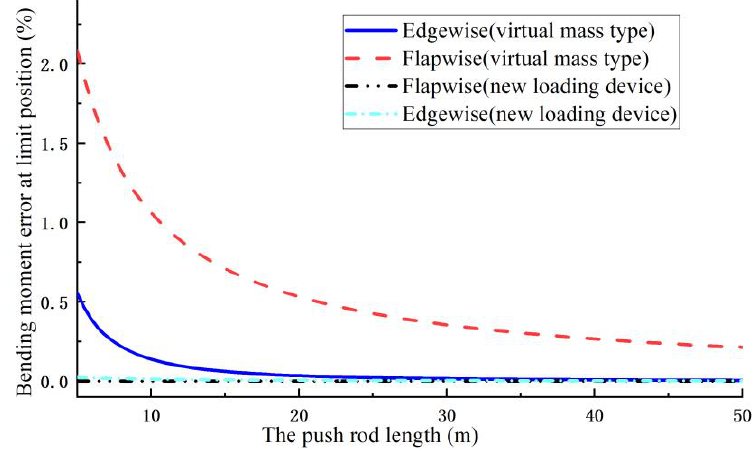
Figure 25. Changing trend of bending moment error of two devices with increasing rod length.